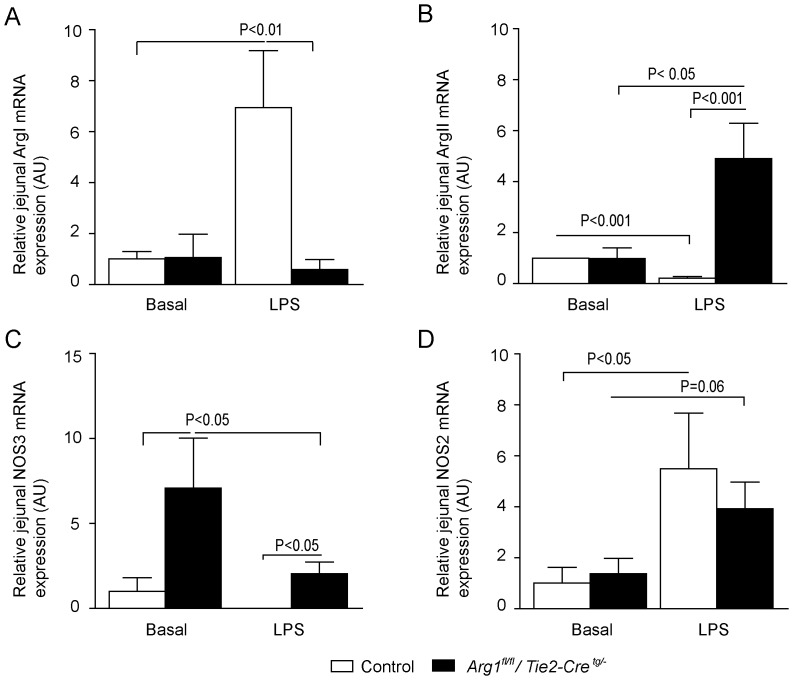
Relative mRNA expression in control and Arg1fl/fl/Tie2-Cretg/− mice under physiological and endotoxemic conditions.(A) Relative Arg1 mRNA expression was significantly higher in the control + LPS group than in basal and Arg1fl/fl/Tie2-Cretg/− + LPS groups. As expected, Arg1 expression was low in Arg1fl/fl/Tie2-Cretg/− mice. (B) Interestingly, the relative Arg2 mRNA expression was significantly higher in the Arg1fl/fl/Tie2-Cretg/− mice after LPS infusion compared to control mice during endotoxemic conditions. (C) LPS infusion resulted in increased Nos2 expression in both mouse strains compared to basal conditions. (D) Nos3 mRNA expression was significantly higher in the Arg1fl/fl/Tie2-Cretg/− mice compared to control animals under basal and LPS-infused conditions (p<0.05). The relative expression of the two household genes Actb and Ppia were used to calculate the geometric mean, which served as a normalization factor.